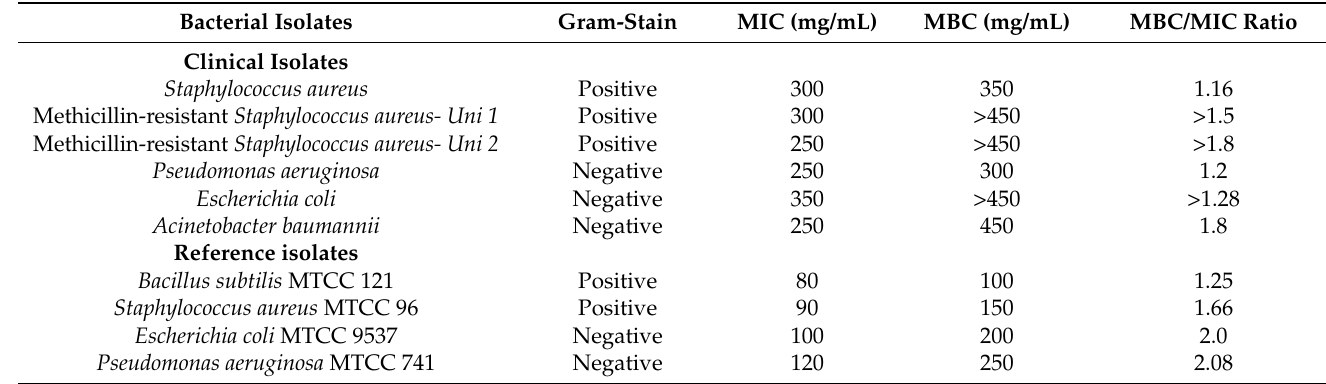
Table 1. Minimum Inhibitory Concentration (MIC) and Minimum Bactericidal Concentration (MBC) of Sumra honey against clinical and reference bacterial strains.